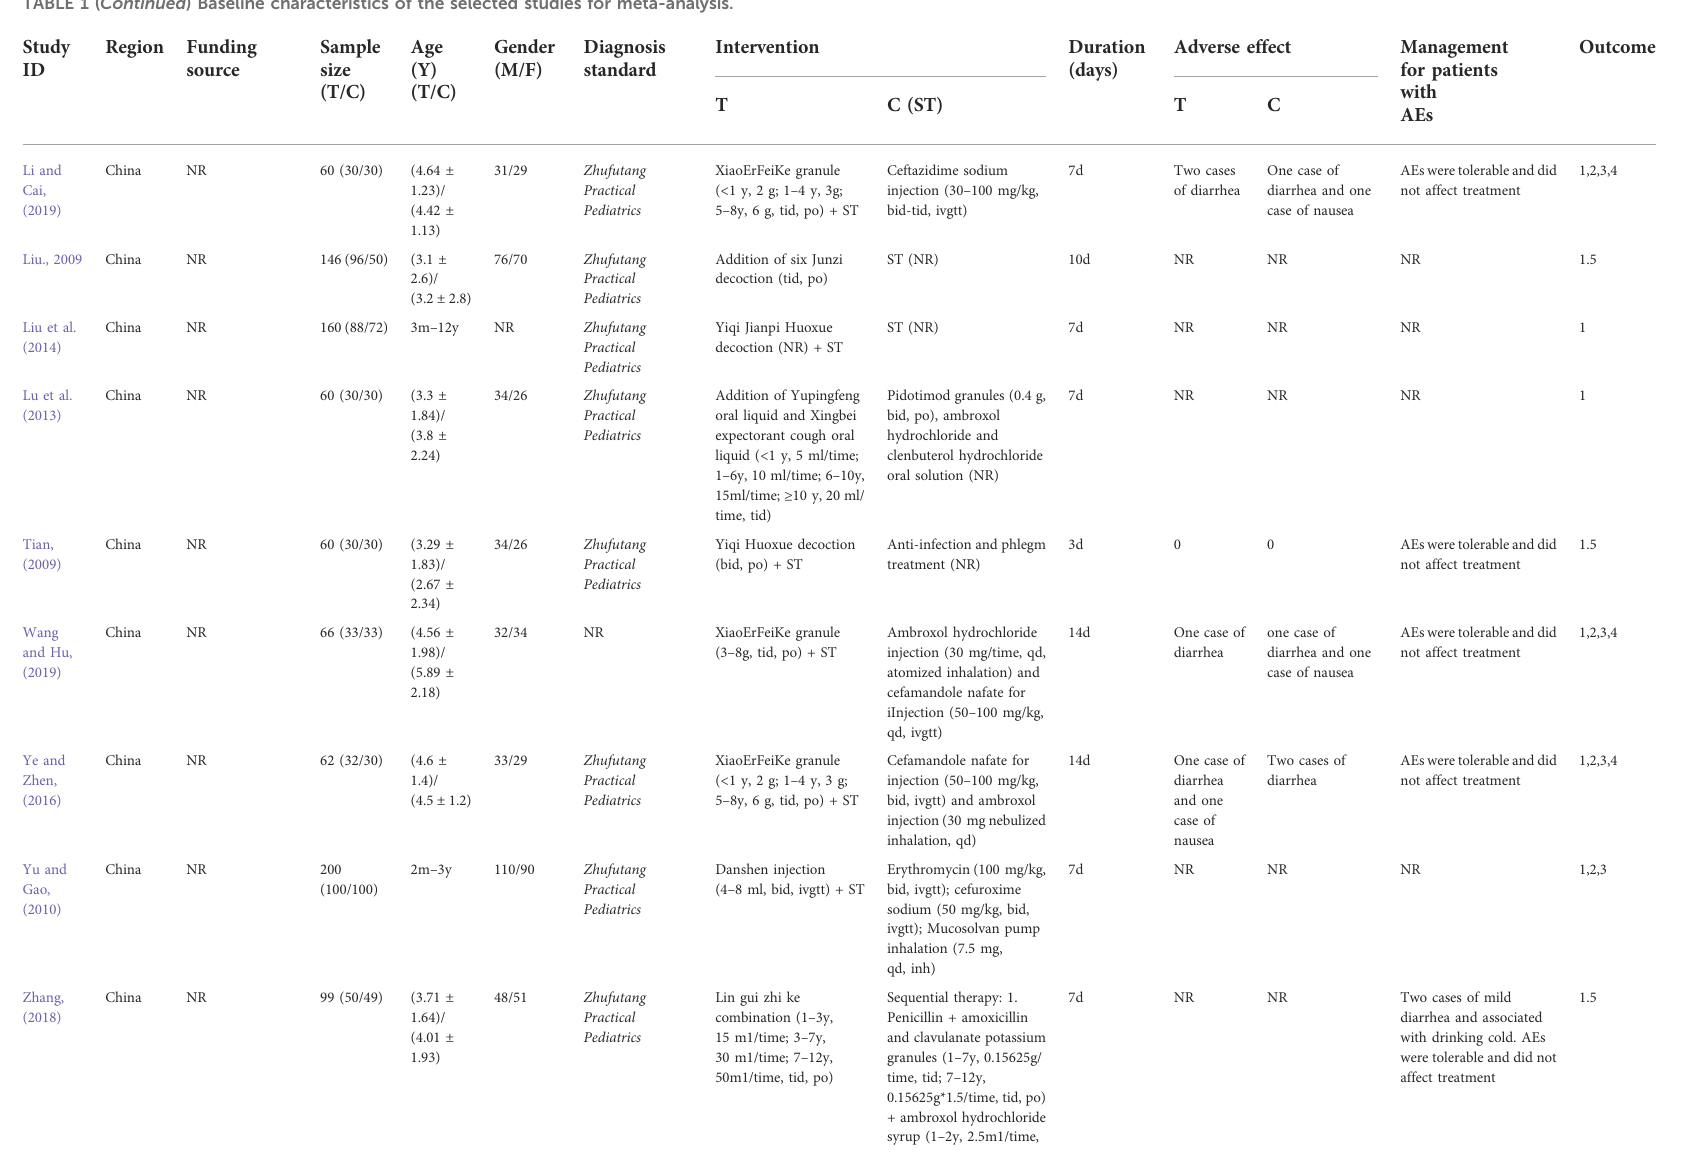
TABLE 1 ( Continued ) Baseline characteristics of the selected studies for